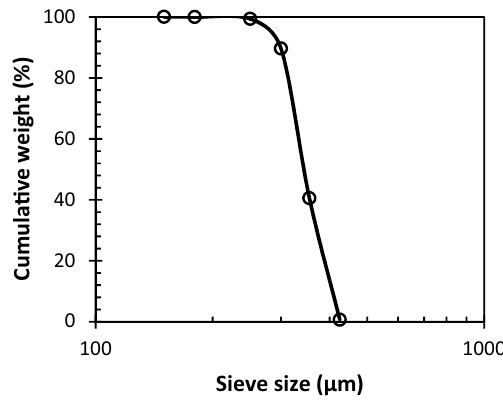
Fig. 5 Grain size distribution of the 40/60 silica